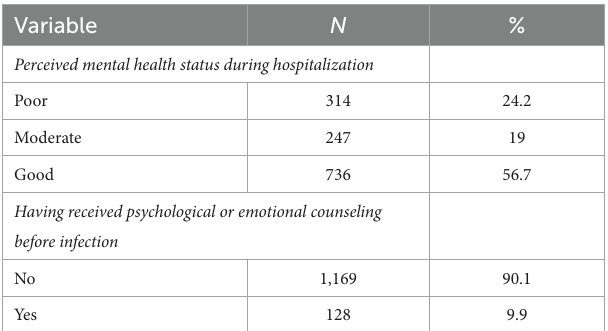
TABLE 1 Demographic characteristics of the